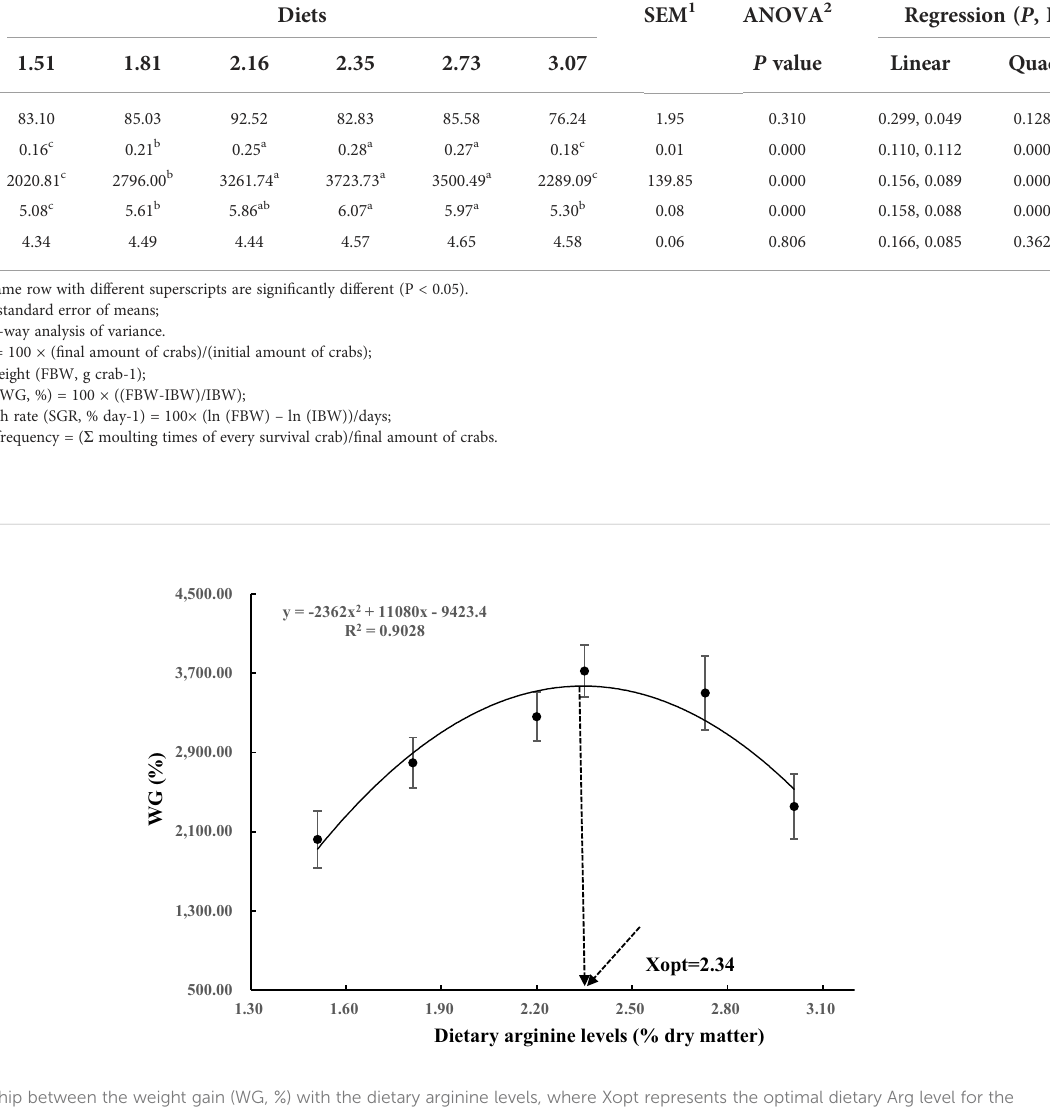
TABLE 5 Growth, feed utilization and morphometrical parameters of postlarval Scylla paramamosain fed with diets containing different arginine levels.